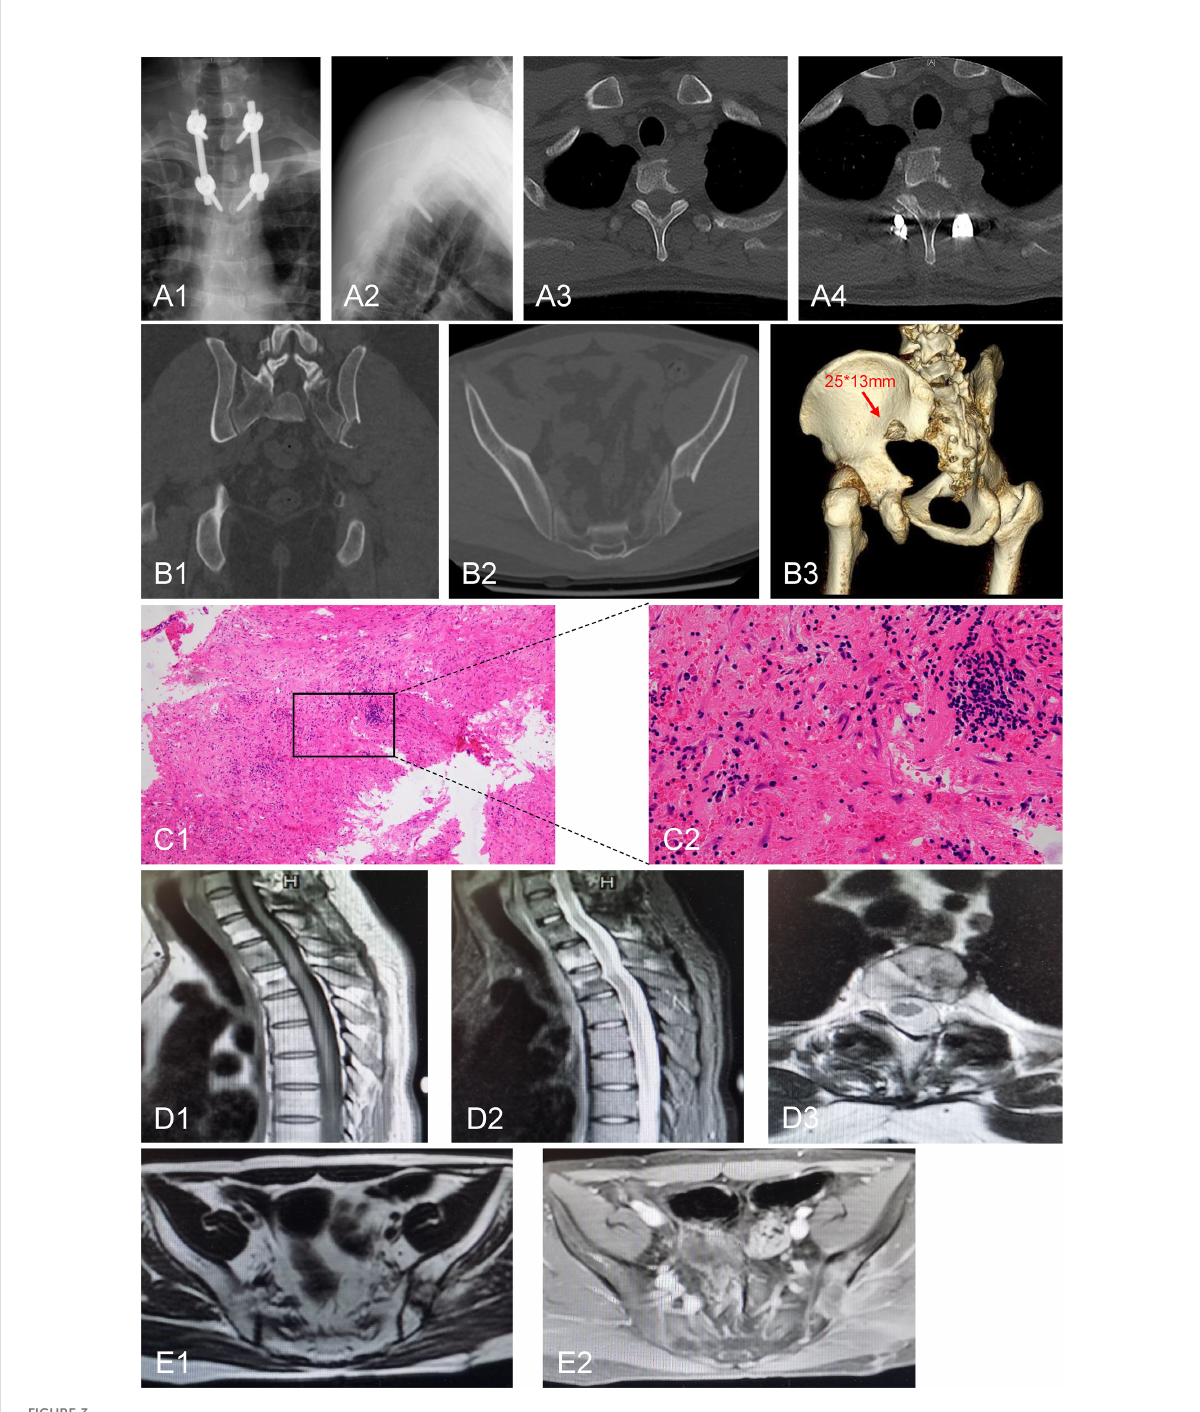
FIGURE 3 Postoperative radiological and pathological images. (A1, 2) Pedicle screw internal fi xation was performed at the level of T1-T3. (A3, 4) Postoperative CT scan showed that the left lamina and the facet joint of T1 and T2 were resected. (B1-3) CT examination of the iliac bone showed that the lesion size was slightly larger than that before the 2-month postoperative follow-up. (C1, 2) H&E staining of iliac bone lesion. (D1-3) Thoracic MRI examination showed no signi fi cant enlargement of the lesion after 15 months of follow-up. (E1, 2) Pelvic MRI examination showed absence of recurrence of the iliac lesion after 15 months of follow-up. C1: 100×; C2: